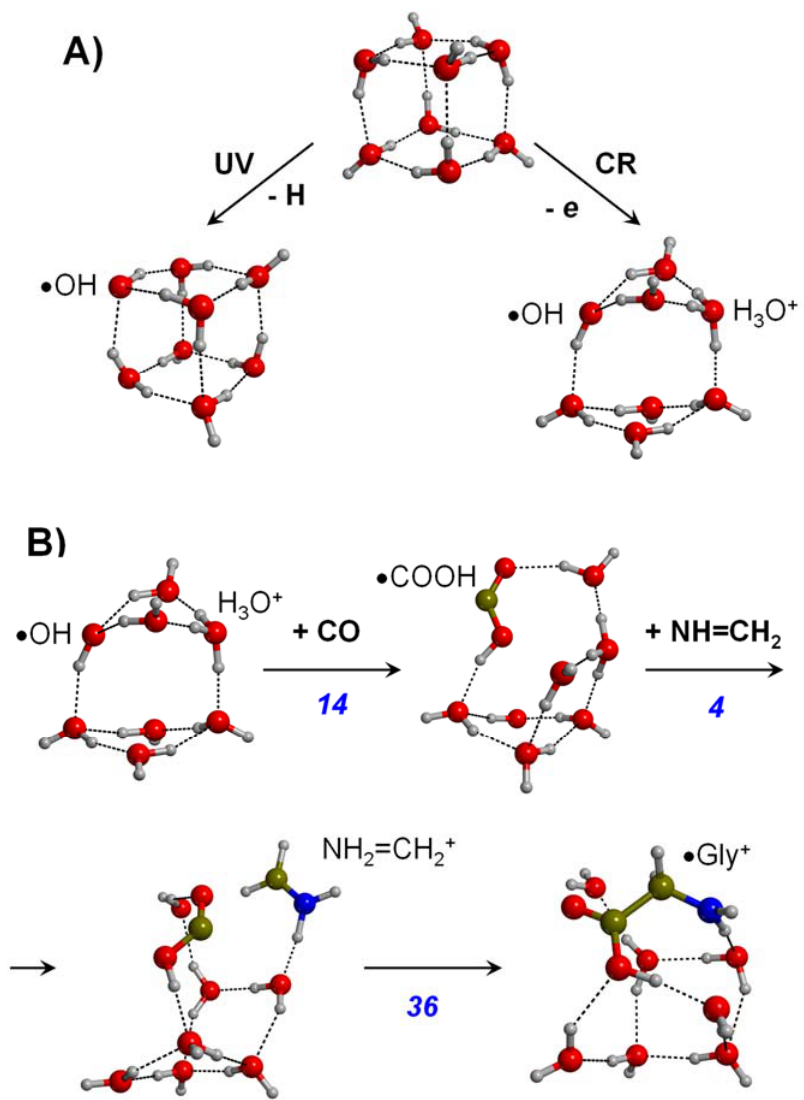
Figure 3. ( A ) Formation of water ice surface defects due to the incidence of ultraviolet radiation (UV) and cosmic rays (CR). ( B ) Chemical sequence to form glycine on the defective water ice cluster model. The numbers in blue are the energy barriers of each step in kJ mol − 1 . Adapted from Ref. [143].